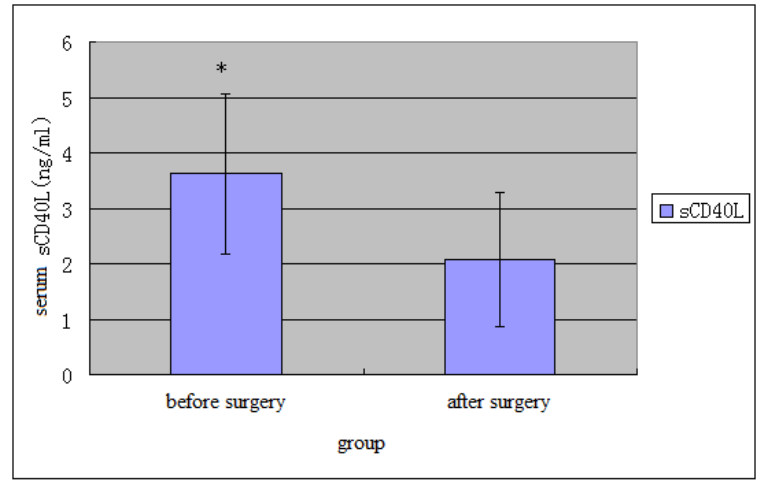
Figure 6. sCD40L levels in before and after surgery, values are mean ± S.D. *P <